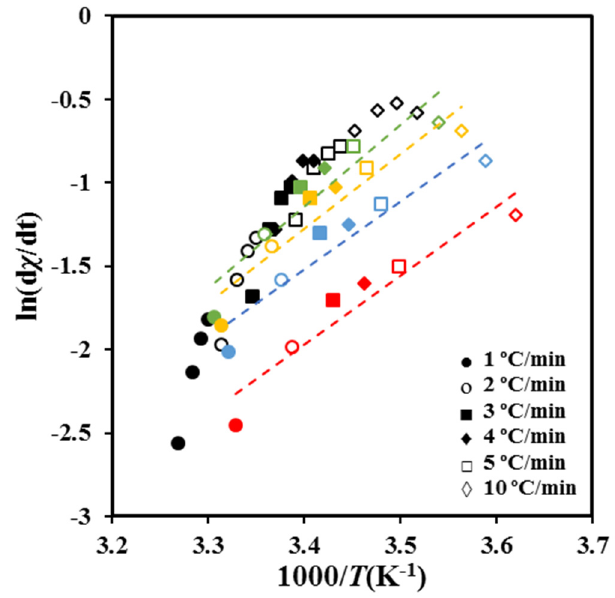
Figure 8. Plots of ln(d χ / dt) χ versus 1 / T for non-isothermal crystallization of P4HB at the indicated cooling rates. Data corresponding to di ff erent relative degrees of crystallinity are represented using symbols and lines of di ff erent colors (i.e., green, yellow, blue, and red correspond to 0.5, 0.6, 0.7, and 0.8 values,